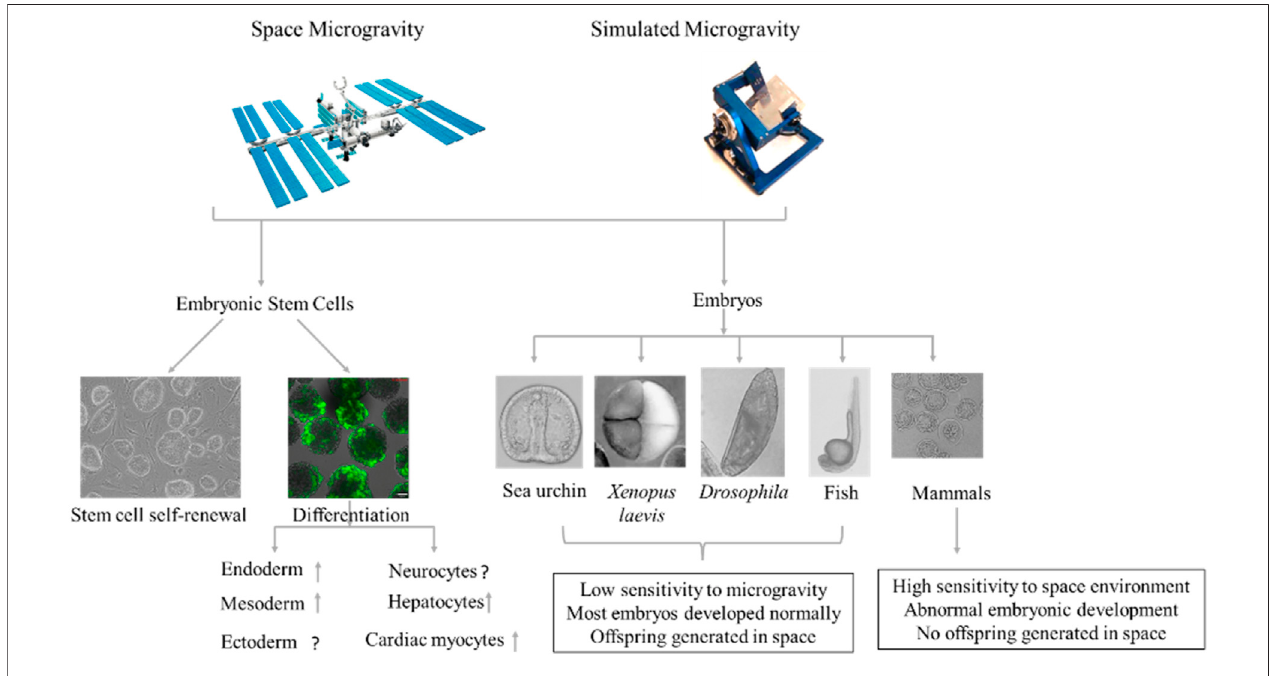
FIGURE 1 | Effects of microgravity on embryonic stem cell (ESC) differentiation and early embryonic development. Microgravity affects ESC self-renewal and differentiation(Left).Spacedoesnotappeartoadverselyaffectembryonicdevelopmentinnon-mammaliananimals,withsomesuccessfullydevelopingandreproducing offspring under microgravity conditions (Ubbels et al., 1989; Vernós et al., 1989; Marthy et al., 1994; Souza et al., 1995; Black et al., 1996; Ijiri, 1998; Schatten et al., 1999). In mammals, however, mice in early-stage pregnancy fail to develop and produce offspring under microgravity, whereas mice in middle- and late-stage pregnancy can successfully produce a viable fetus during space fl ight and give birth to live pups after landing (Wakayama et al., 2009; Kojima et al., 2000; Jung et al., 2009; Ma et al., 2008; Mishra and Luderer, 2019).